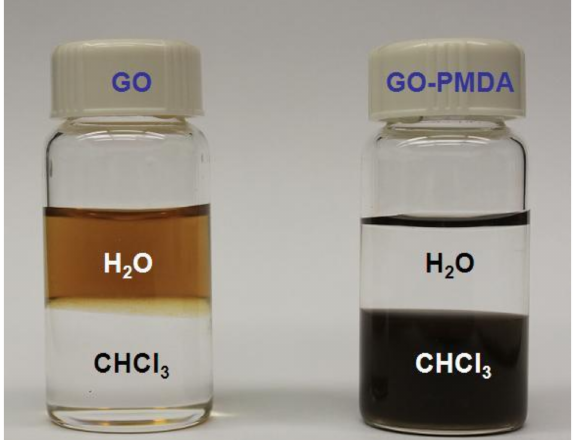
Figure 1. Solubility of GO and